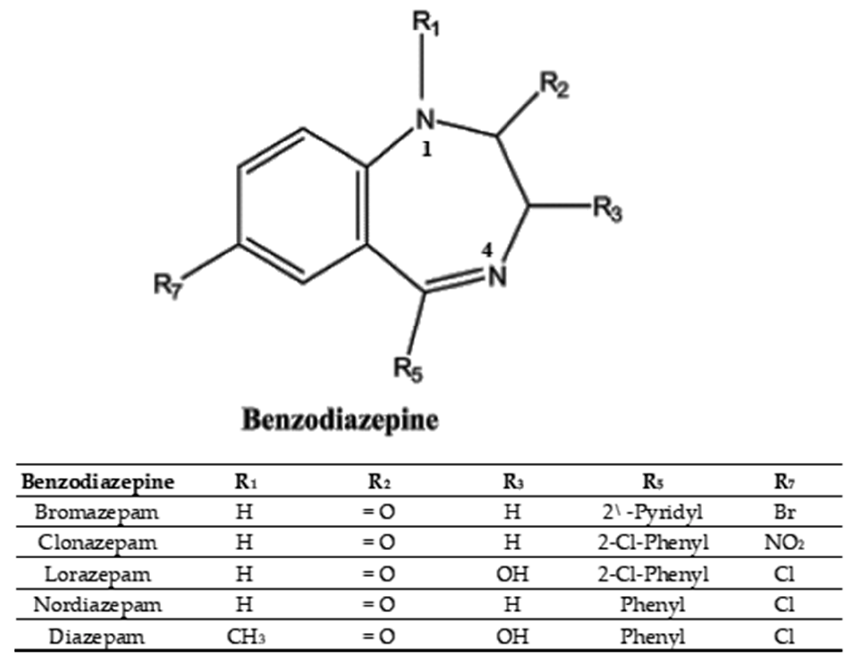
Figure 1. Chemical structures of the five benzodiazepines (BZDs) studied drugs.